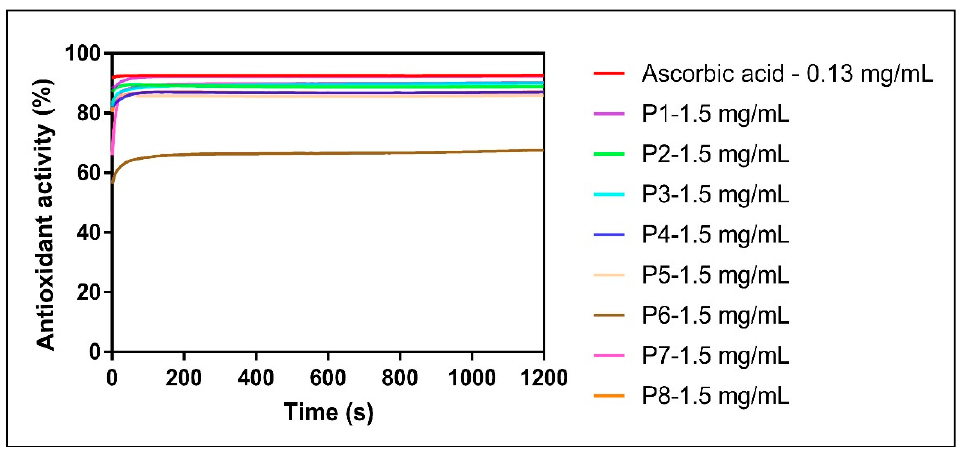
Figure 6. The time-dependency of radical scavenging activity for P2 sample vs. ascorbic acid. The IC 50 values (Table 3) varied from 0.0700 mg/mL for the P2 sample (the highest antioxidant capacity) to 0.9945 mg/mL (the lowest antioxidant capacity) in case of P6 sample. TheIC 50 variation of the Western Romanian propolis samples is displayed in Figure 7.